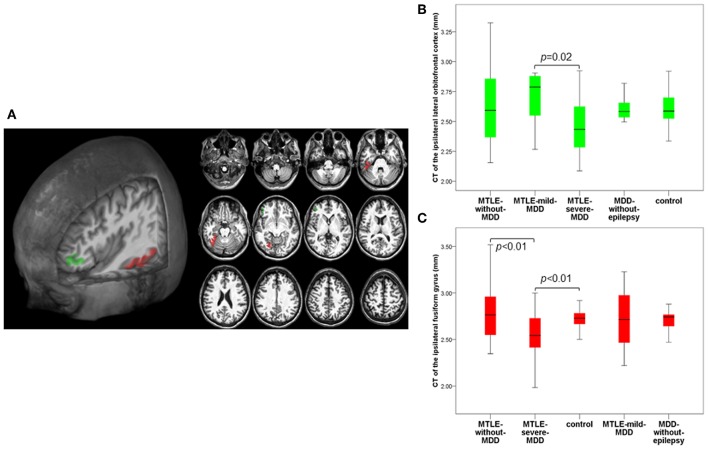
Composition panel illustrating CT reduction in the ipsilateral lateral orbitofrontal cortex (green) and in the ipsilateral fusiform gyrus (red). (A) 3D and 2D automated FreeSurfer segmentation of the ipsilateral lateral orbitofrontal cortex and the ipsilateral fusiform gyrus. (B) Cortical thickness abnormalities in the ipsilateral lateral orbitofrontal cortex according to the groups. (C) Cortical thickness abnormalities in the ipsilateral fusiform gyrus according to the groups. CT, cortical thickness; MTLE, mesial temporal lobe epilepsy; MDD, Major Depressive Disorder; MTLE-without-MDD, MTLE patients without depression; MTLE-mild-MDD, MTLE patients with mild symptoms of depression; MTLE-severe-MDD, MTLE patients with moderate to severe symptoms of depression; MDD-without-epilepsy, patients without epilepsy with MDD.